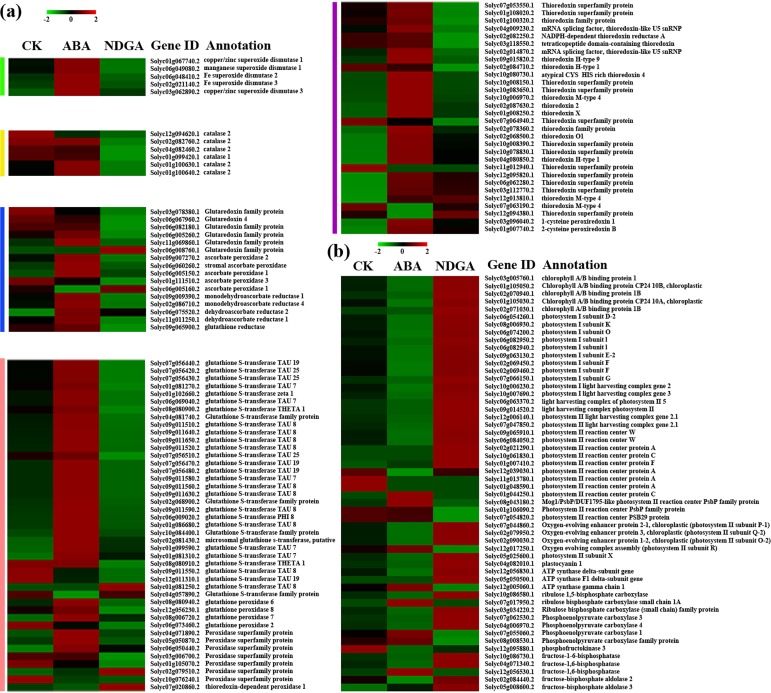
Analysis of DEGs involved in the pathway of ROS-scavenging and photosynthesis, respectively.(a) Expression profiling of DEGs involved in antioxidant system. Green bar, SODs; yellow bar, CATs; blue bar, genes encoding enzymes of GSH-ASA cycle; pink bar, genes encoding enzymes of GPX pathway; purple bar, genes encoding enzymes of PrxR/TrX pathway. (b) Expression profiling of DEGs encoding key enzymes in different steps of photosynthesis.